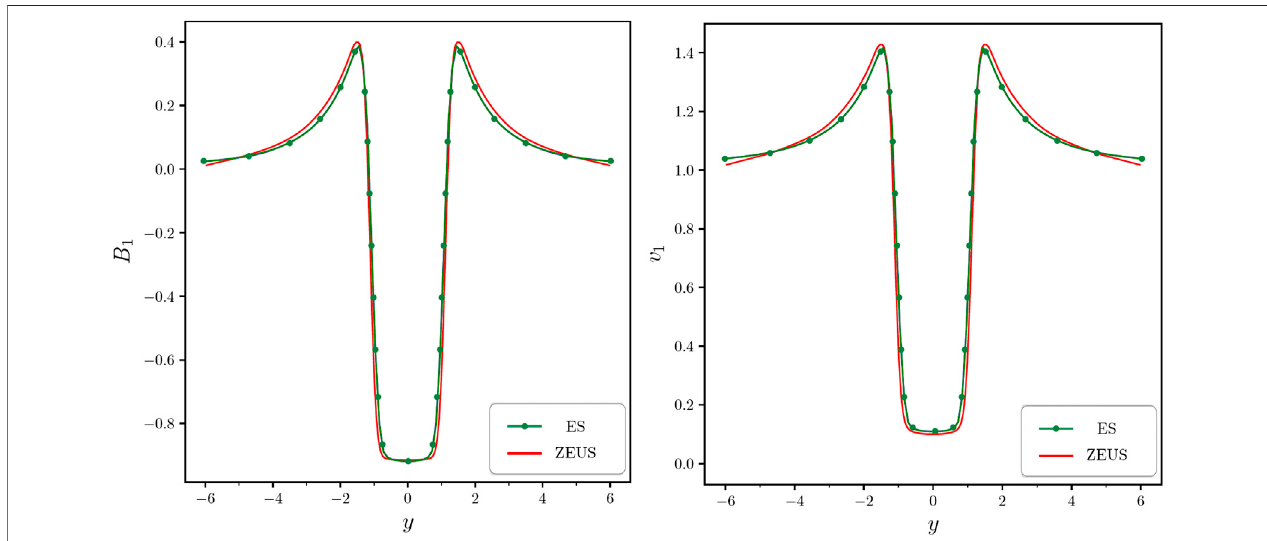
FIGURE 6 | One dimensional visualization of the Alfvén wing solution along the line z (cid:3) 5 from the xz plane slice at y (cid:3) 0. A comparison is performed between the entropyDGsolverwith N (cid:3) 3ineachspatialdirectionandthe fi rstorder fi nitevolumesolverZEUS.TheentropystableDGapproximationuses90%fewerDOFcompared to the 10 million DOF used for the ZEUS computation. Qualitatively, the solutions are very similar.